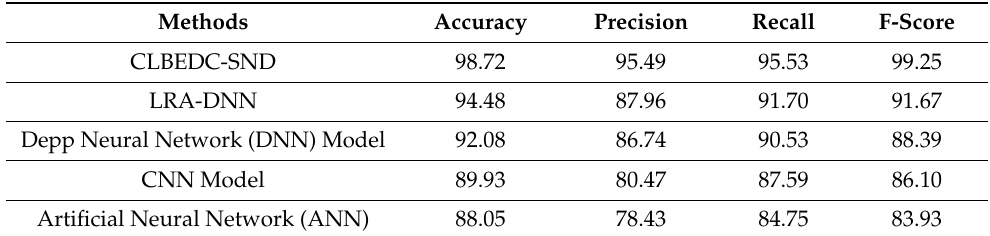
Table 5. Comparative analysis of CLBEDC-SND approach with existing algorithms.